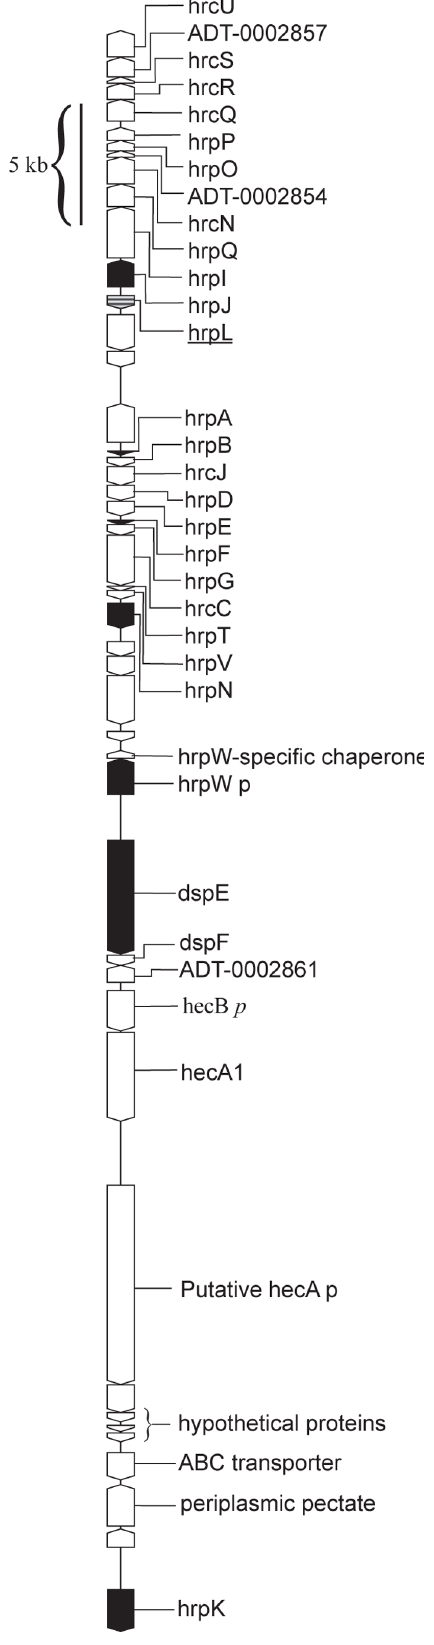
Figure 2. The Hrp pathogenicity island of P.carotovorum strain WPP14 (GenBank accession NZ_ABVT00000000). Black fill denotes detection in the fluorescence based promoter trap screen, and p indicates pseudogenes that have yet to be further examined. This figure was made from a draft genome sequence and it is likely that hecA1 and putative hecA represent a single